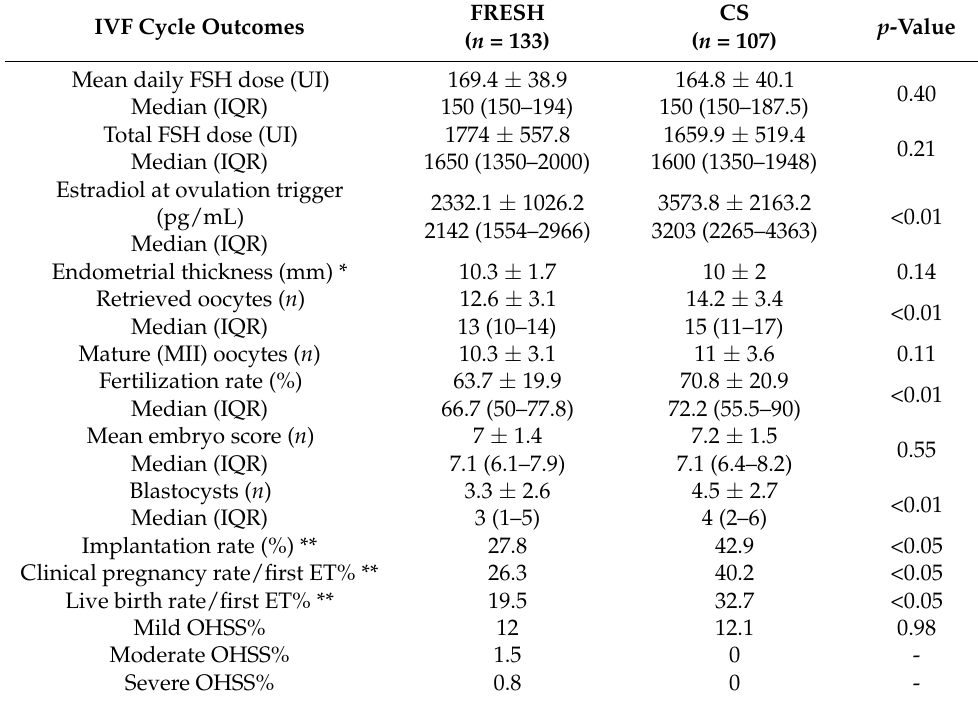
Table 2. In vitro fertilization (IVF) outcomes of patients receiving fresh ET plus hCG luteal supple- mentation (FRESH group) vs. those undergoing cycle segmentation with freezing of all embryos and delayed ET (CS group). Data are expressed as mean ± standard deviation and median (IQR), if appropriate, for quantitative variables and percentages for qualitative variables. * Endometrial thickness in the FRESH group was measured during oocyte pick up (OPU), whereas in the CS group, it was measured the day after LH urinary peak during the spontaneous cycle in which ET with thawed embryo was performed. ** In both groups, only the first ET was considered. OHSS: ovarian hyperstimulation